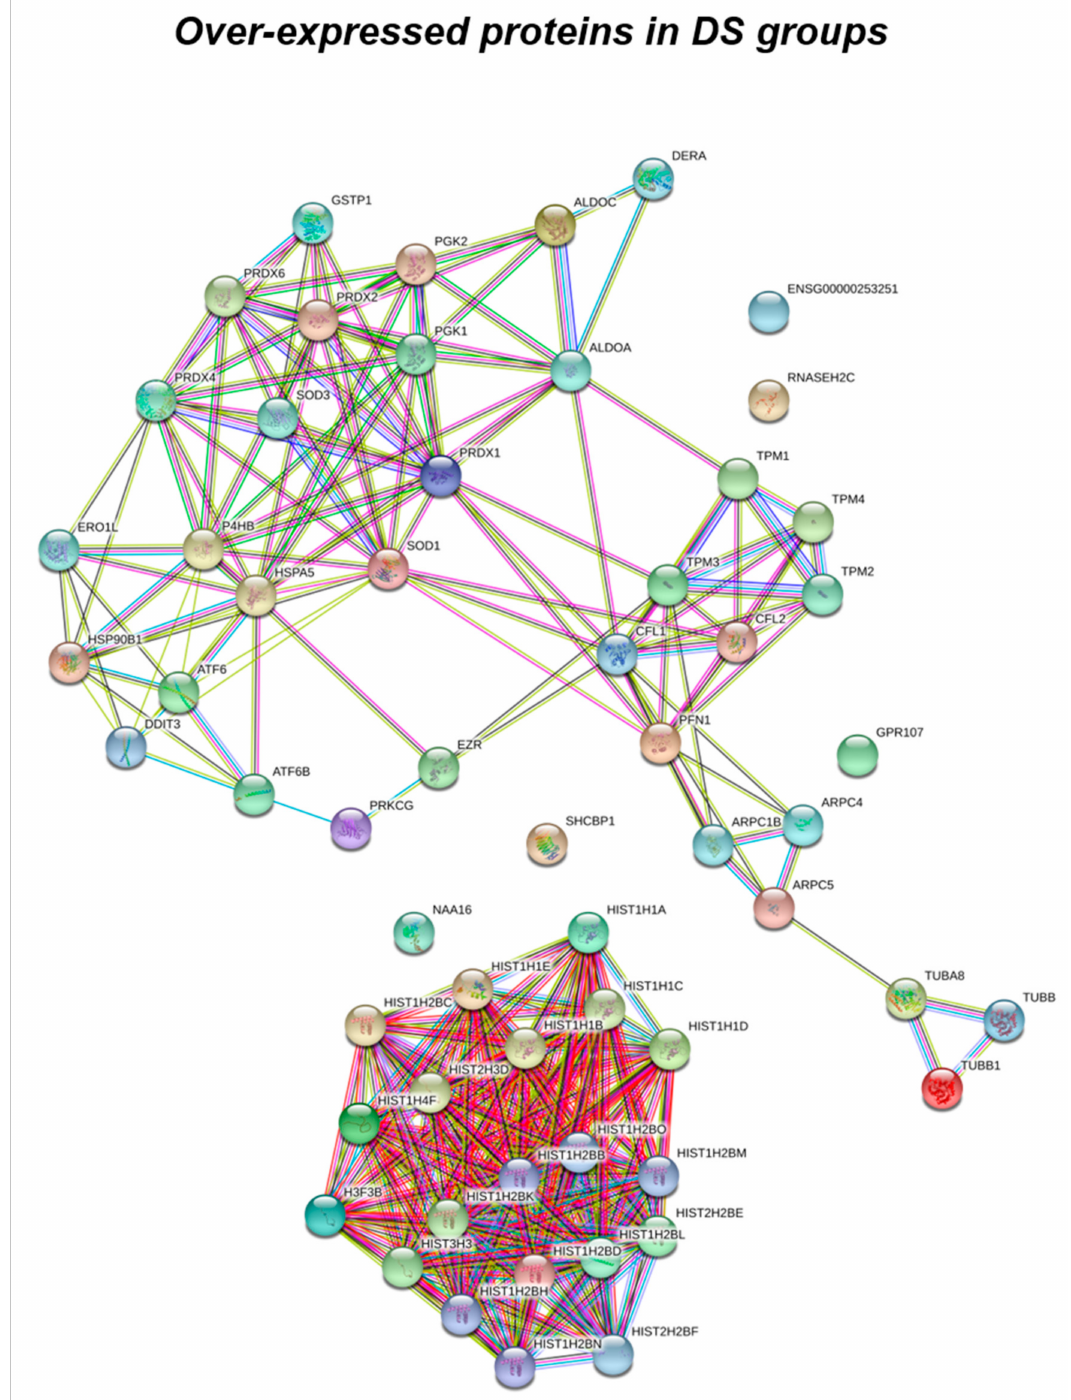
Figure 2. Functional network enrichment in the DS